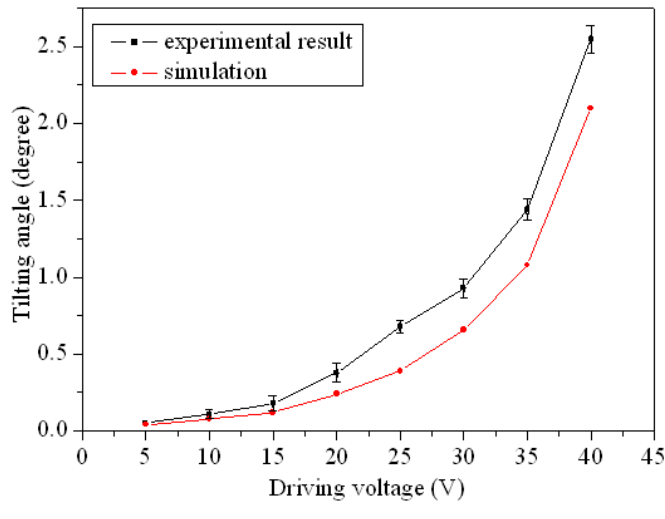
Figure 9. Tilting angles of the mirror at various driving voltages.